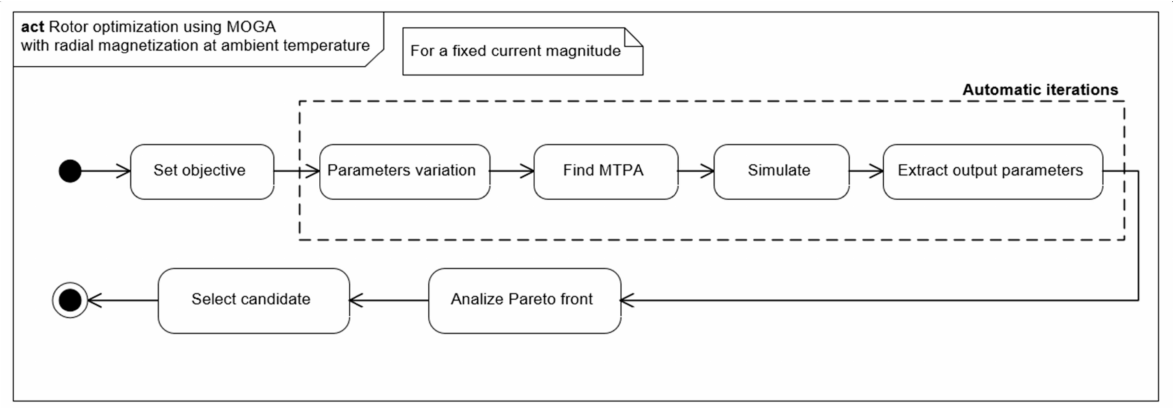
Figure 13. Stator optimization activity diagram.